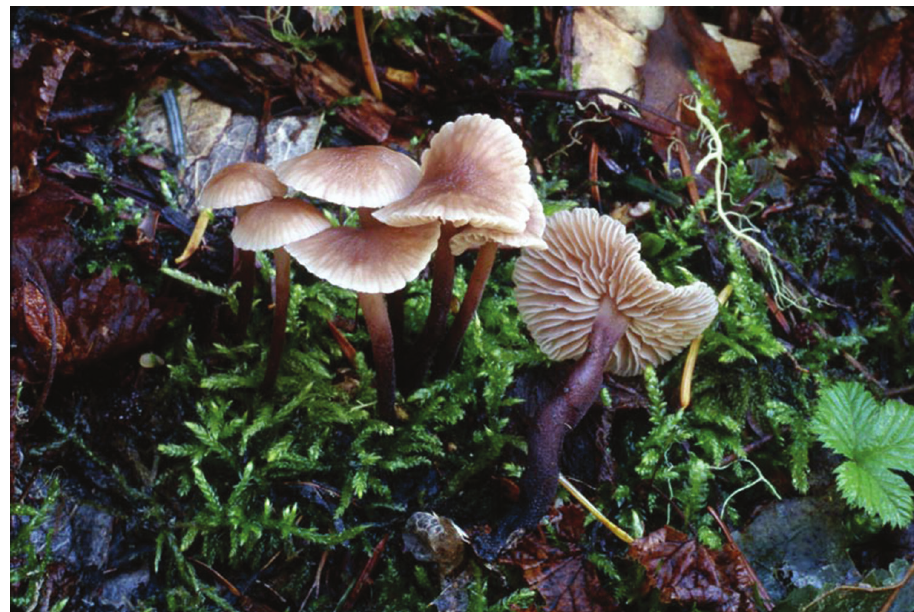
Figure 64. Mycetinis salalis . Photo in natural habitat. Photo courtesy of Steve Trudell. WTU-F